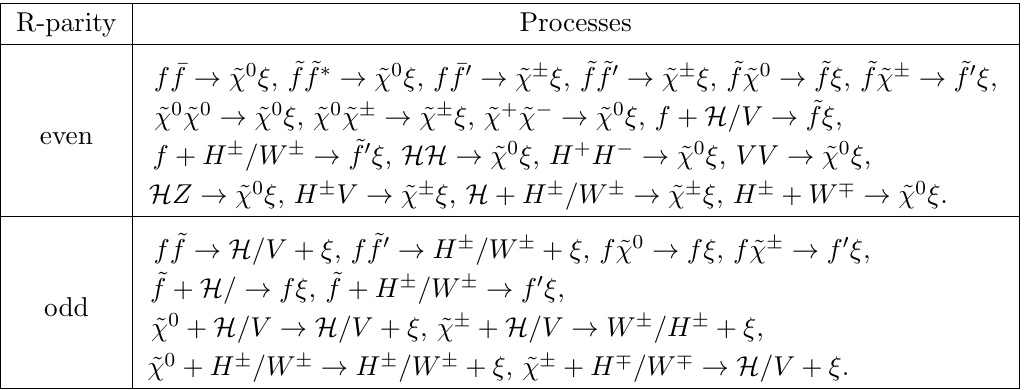
Table 7. An exhibition of A + B ! C + (cid:24) type processes relevant for producing the ultraweakly interacting particle (cid:24) .